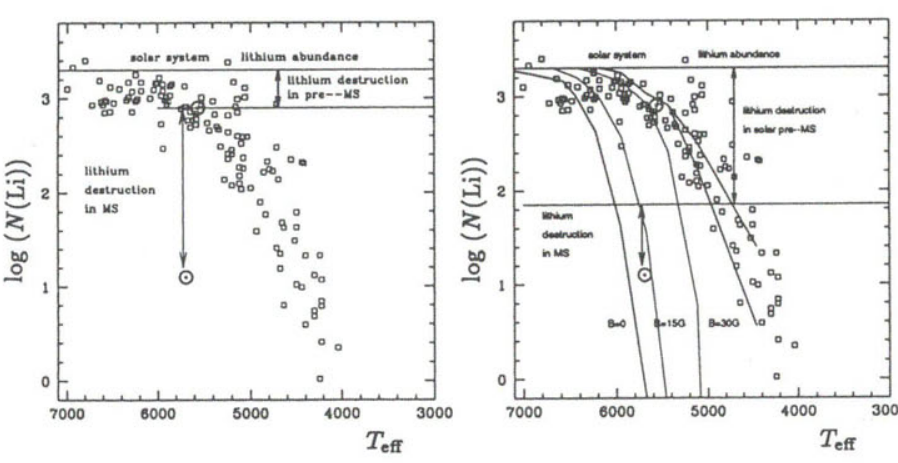
Fig. 2. The open squares represent the lithium versus T e ff abun- dances in the Pleiades open cluster. On the left: the "simple minded" view of lithium depletion in a star of 1M©, assuming that pre-MS deple- tion for the Sun has been the same as for the lAf©star in the Pleiades and that the present solar abundance (log N(Li) ~ 1.1) is reached through the "slow" main sequence depletion mechanisms. On the right, the curves show the pre-MS lithium depletion in the models including an approximate treatment of the influence of the dynamo magnetic field on the convective structure (Ventura et